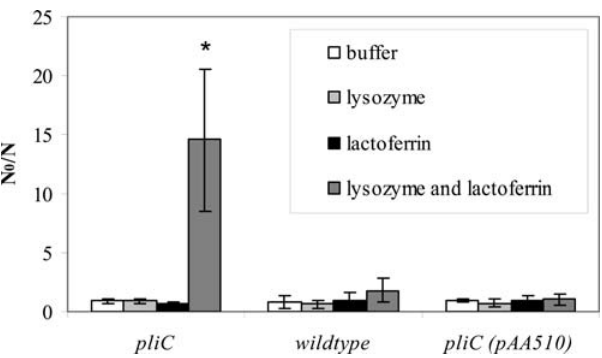
Figure 3. Sensitivity of S. Enteritidis strains to lysozyme in the presence of lactoferrin. Inactivation (N o /N) of S. Enteritidis pliC , S. Enteritidis and S. Enteritidis pliC (pAA510) after 24 h of incubation with 10 mM Tris-HCl pH 7.0 ( % ), 100 m g/ml lysozyme ( & ), 3.0 mg/ml lactoferrin ( & ) and lysozyme and lactoferrin together ( & ). Mean values 6 standard deviations (error bars) are shown (n=4). Lysozyme treatments resulting in significant differences (p , 0.01) compared to the same treatments without lysozyme are marked with an asterisk.